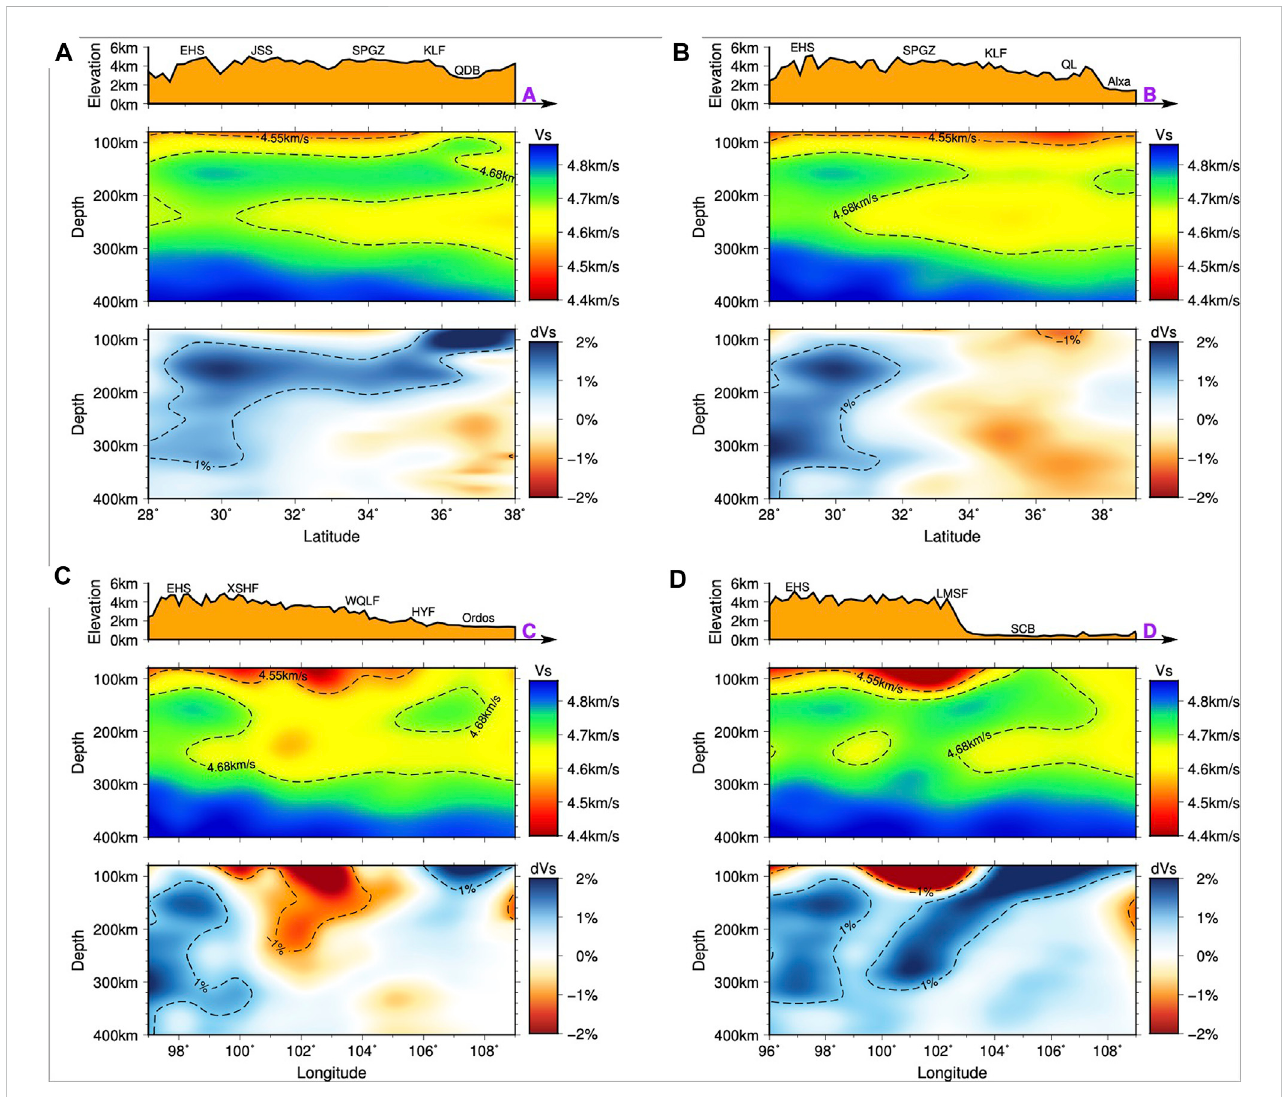
FIGURE 4 Verticalcross-sectionsofshearwavevelocityofpro fi leA (A) ,B (B) ,C (C) andD (D) .Thelocations ofthecross-sections areshowninFigure3A.Theblack solid and dotted lines represent the surface topography and contour of the seismic velocities, respectively. The perturbation is calculated relative to the 1-D mean velocity model of the research